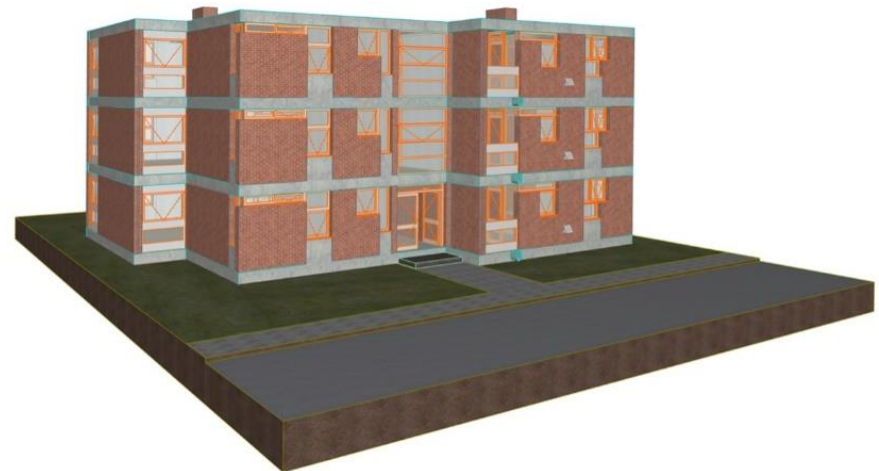
Figure 9. Navigable virtual model, view of the main front.